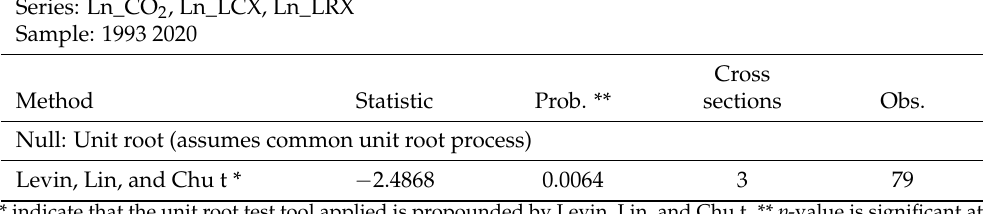
Table 2. Unit root test summary.